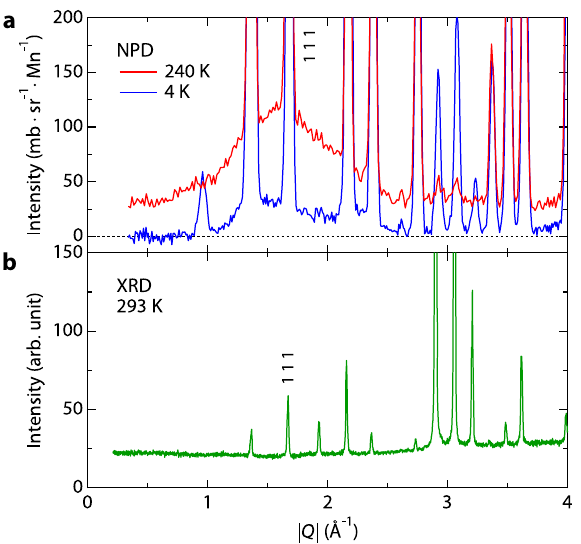
Fig. 2 Enlarged neutron and X-ray diffraction patterns. a , b Diffuse scattering under nuclear Bragg peaks of neutron diffraction patterns at T = 240 and 4 K on an absolute scale ( a ) and the X-ray diffraction pattern at T = 293 K ( b